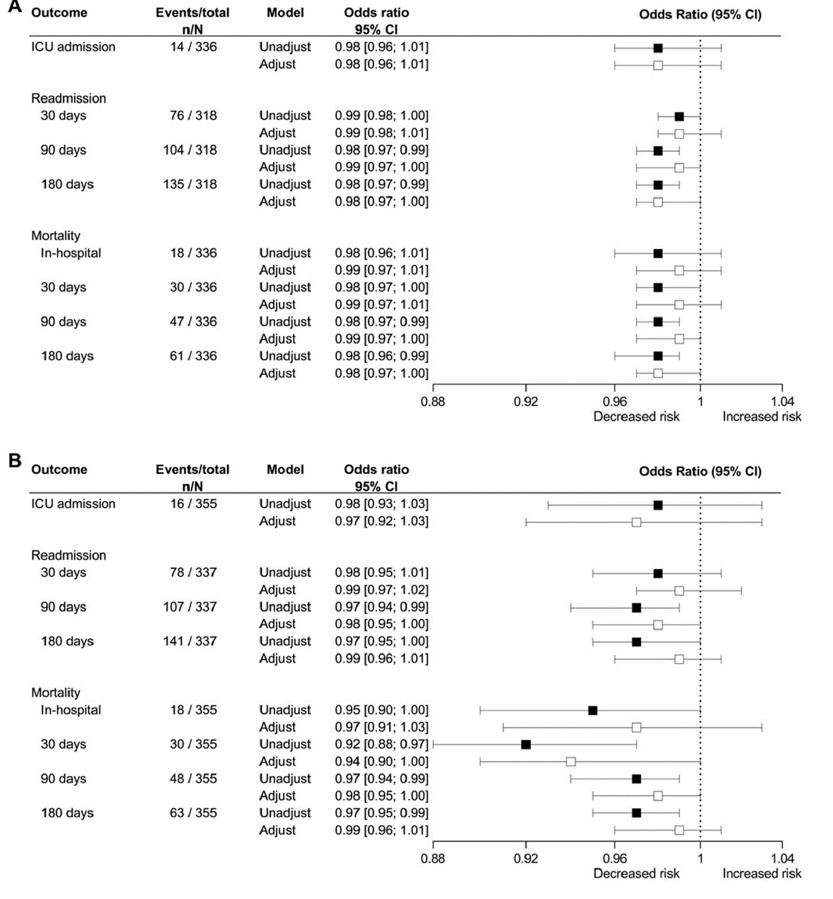
Figure 1. Association between Barthel index ( A ) and grip strength ( B ) and prognosis among 355 patients admitted with community-acquired pneumonia. The association between Barthel index and grip strength and risk for admission to the intensive care unit (ICU), readmission, and mortality were analyzed in an unadjusted logistic regression model (black) and a logistic regression model adjusted for age and sex (white). The patients who died in the hospital are not included in the anal- yses for readmission.